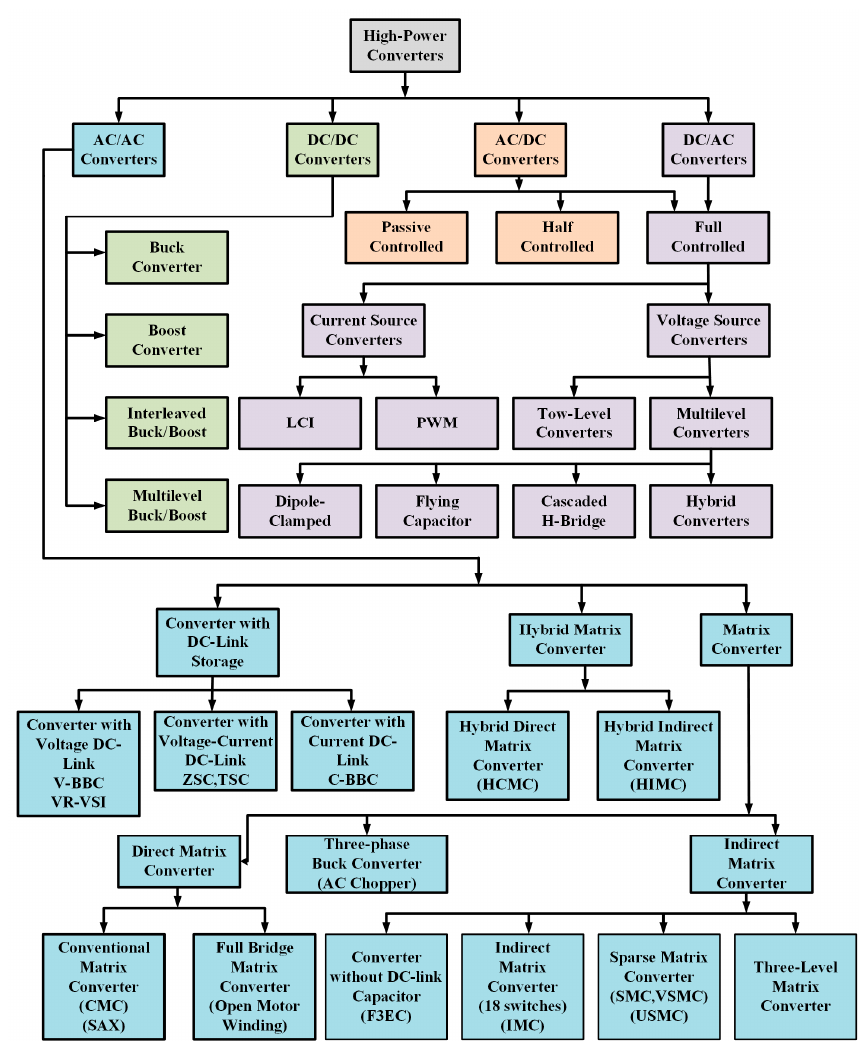
Figure 40. Detailed classification of converters. Data from [92,93].